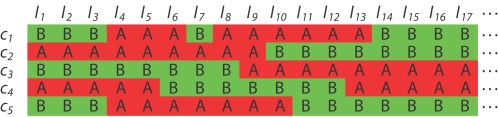
An example of a singleton (double crossover).Each row refers to an individual and each column refers to a marker locus. Given the current order, the entry (c
1, l
7) appears to be a possible error because its state differs from both its immediately preceding and following markers.